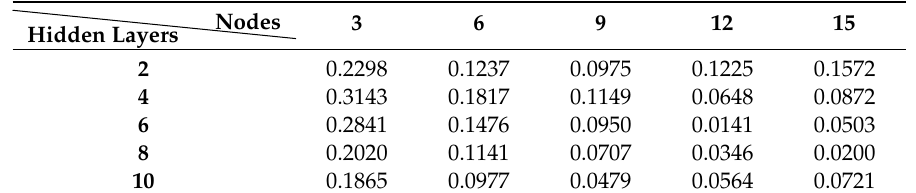
Table 2. RMSE of di ff erent hidden layers and nodes.